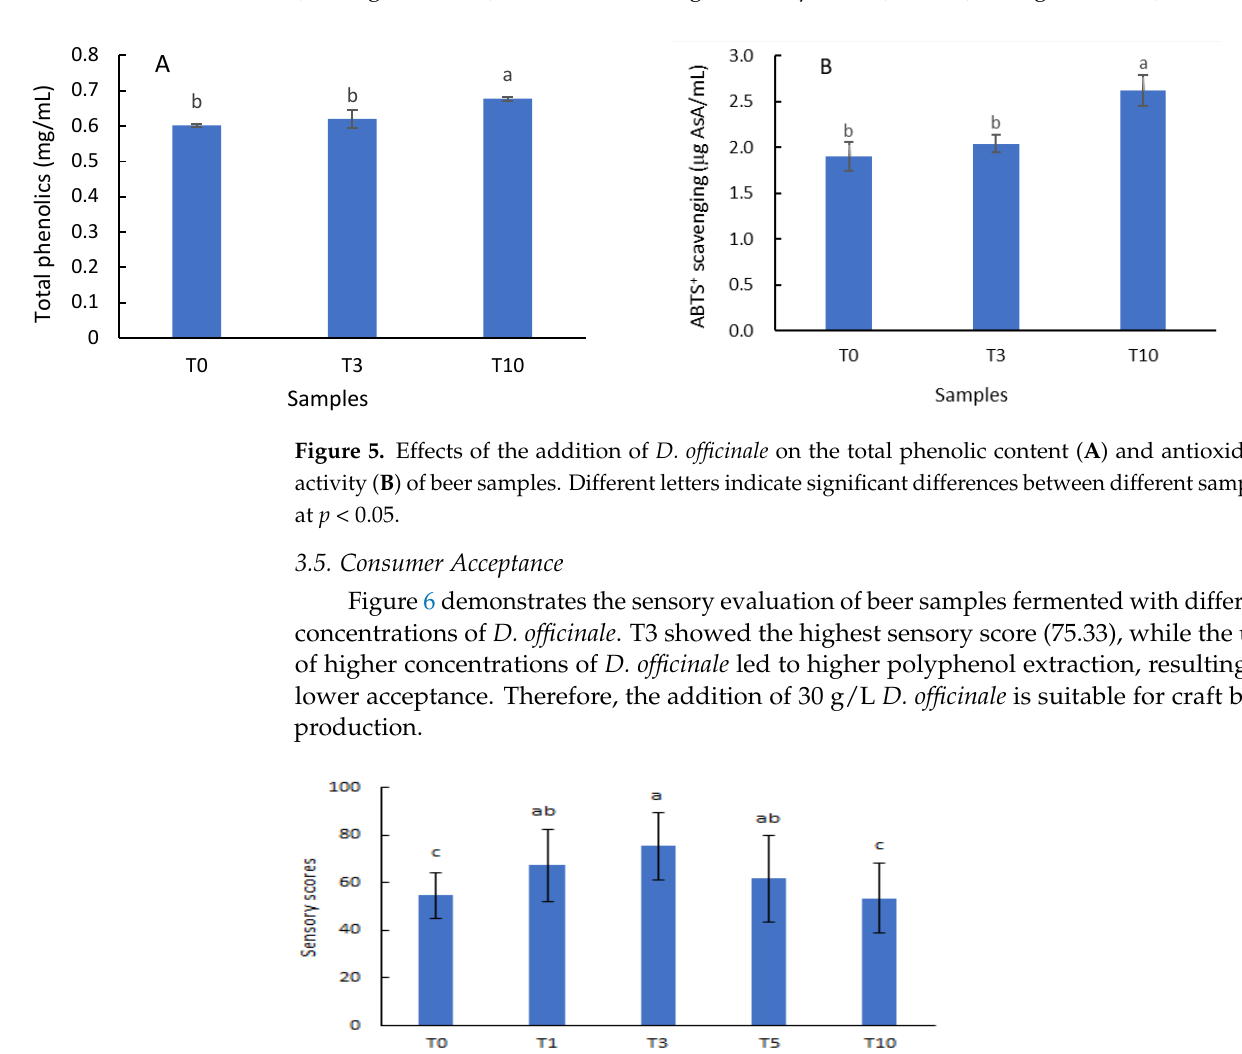
Figure 4. Effects of D. officinale on the activities of alcohol dehydrogenase (ADH) and glucose-6- phosphate dehydrogenase (G6PDH) in S. cerevisiae . Different letters indicate significant differences between different samples at p < 0.05.